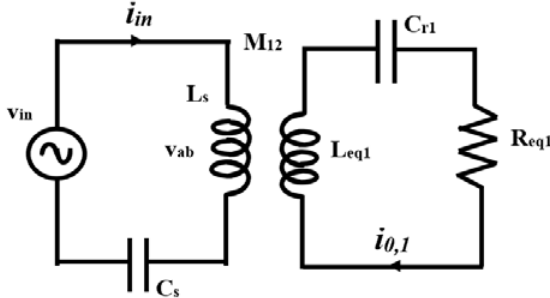
Figure 5. Equivalent model of IH system with